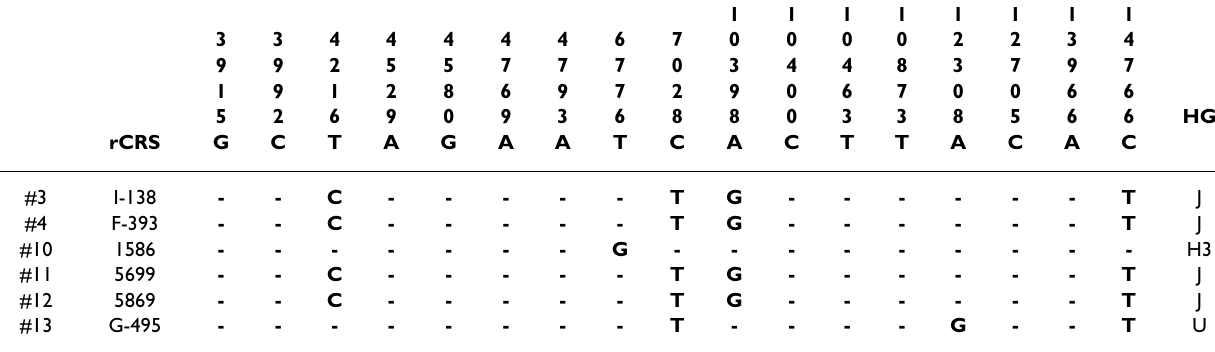
Table 5: Coding SNP and haplogroup status of the Galician